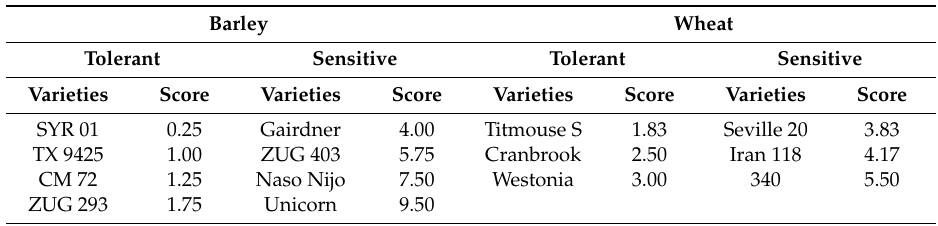
Table 1. List of barley and wheat varieties used in this study. Scores represent quantified damage degree of cereals under salinity stress, reported as damage index score from 0 to 10.